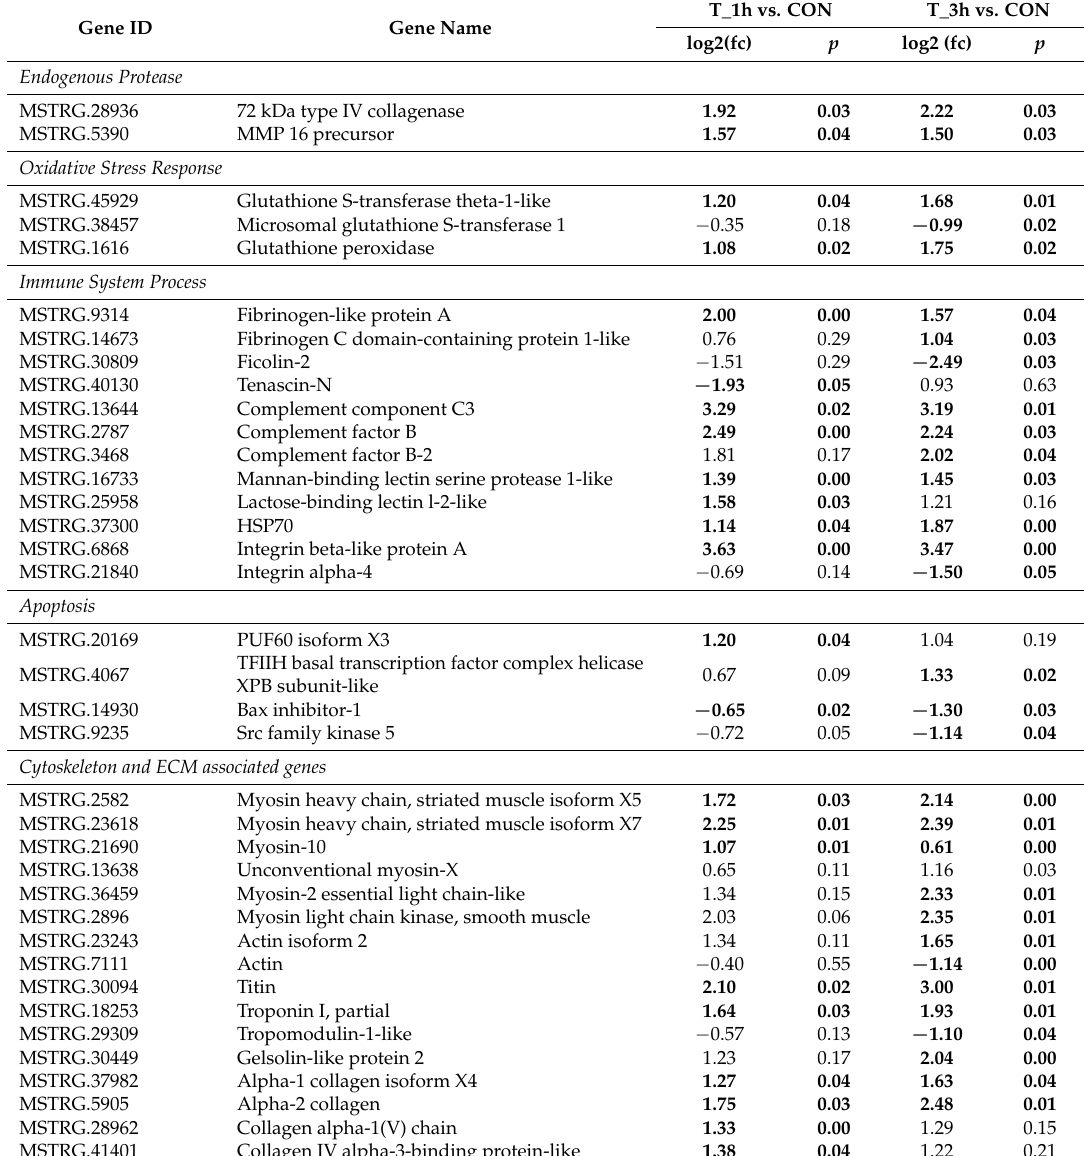
Table 3. Special types of the main DEGs in AJBW during